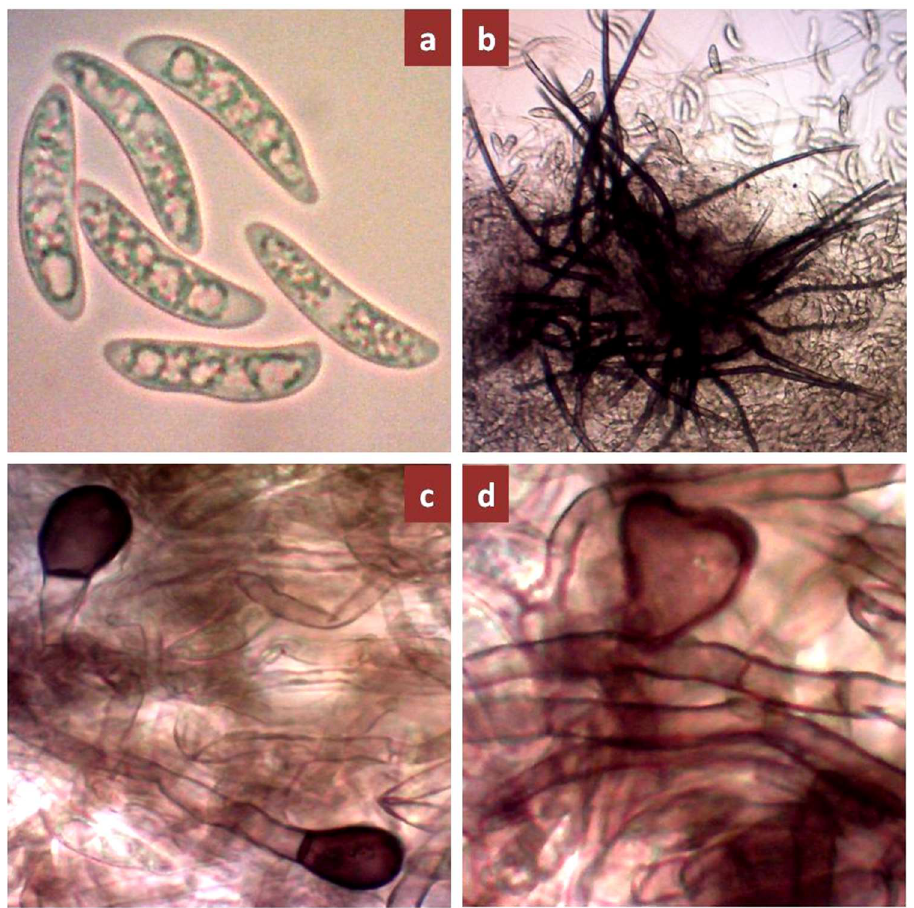
Figure 3. Microscopic features of C. falcatum isolates from Bangladesh ( a ) Conidia ( b ) Setae ( c ) Globose type appressoria ( d ) Clavate type appressoria.